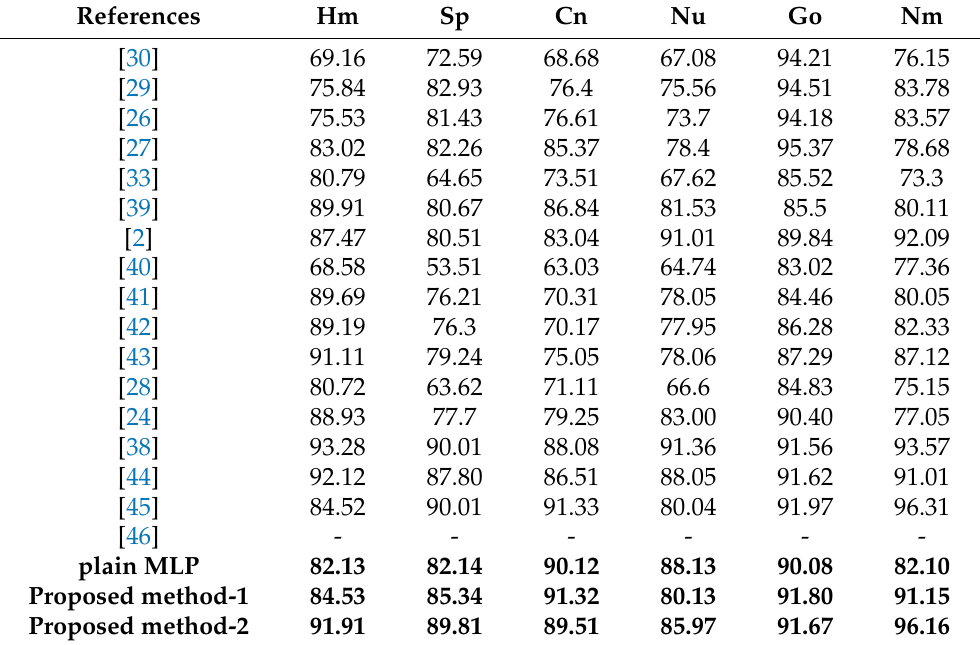
Figure 7. Correct classification rates (CCR) for each cell class and mean value of methods comparing with our proposed method to show the variation in classification of each class. Table 3. Confusion matrix parameters Classification results of comparable methods of ICPR2014, ICPR2016 and recent techniques using the Task-1 data set for each